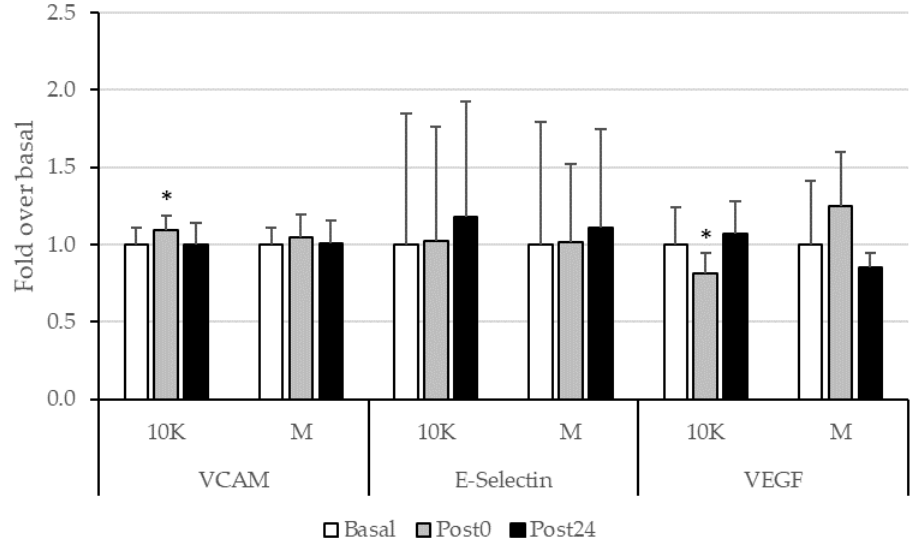
Figure 5. Adhesion molecules (VCAM-1 and E-Selectin) and VEGF, expressed as fold over Basal, trough the different races and timepoints. 10K: 10 km race; M: Marathon race. Basal: sample collected within 1 h before each race; Post0: sample collected within 10 min after the race; Post24: sample collected 24 h after Basal. * Significantly different ( p < 0.05) from Basal. Data are presented as mean ± standard deviation. Sample size, N = 9.